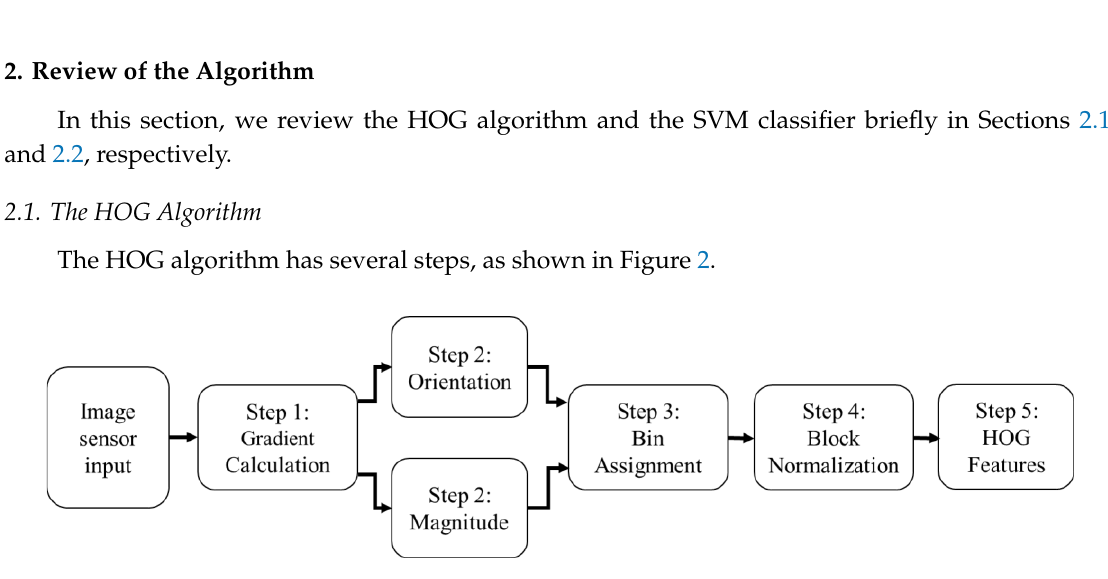
Figure 2. A flowchart of the HOG algorithm from input image sensor to HOG features.